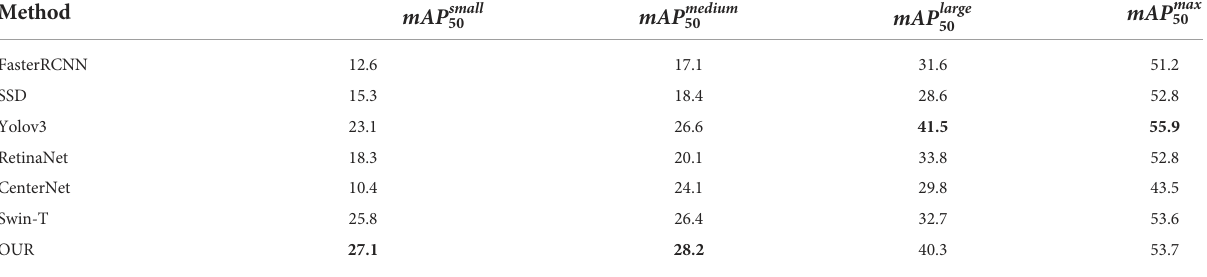
Bold values indicates the best detection result in each